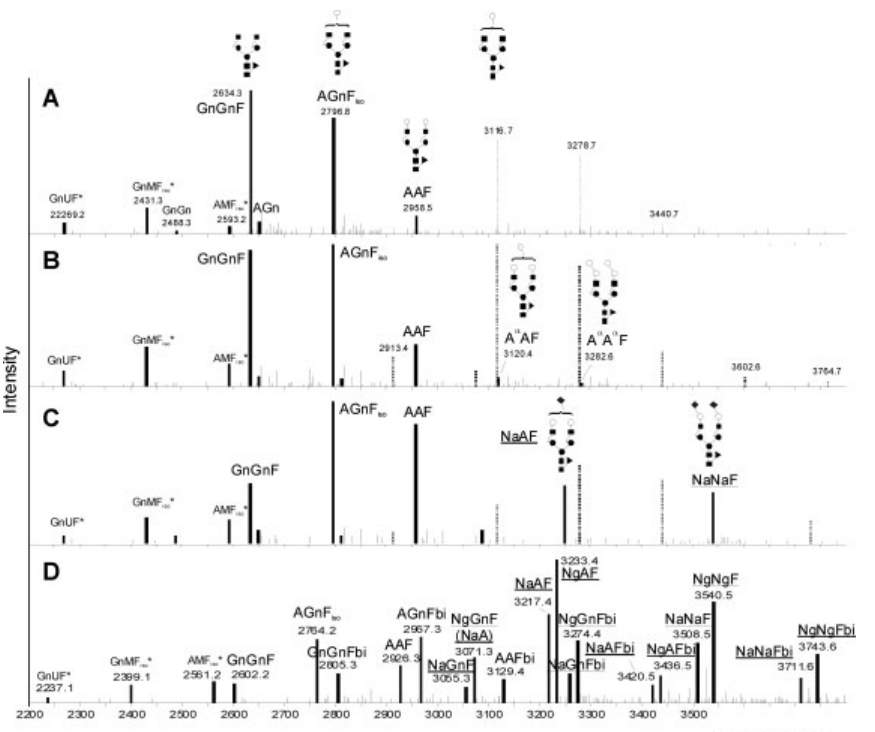
Figure 4. Glycopeptides from three mAbs and from guinea pig IgG: the deconvoluted spectra of (A) the glycopeptides from Rituximab; (B) Daclizumab (Zenapax); (C) CHO-cell pro- duced 4E10; and (D) guinea pig IgG are shown. See also